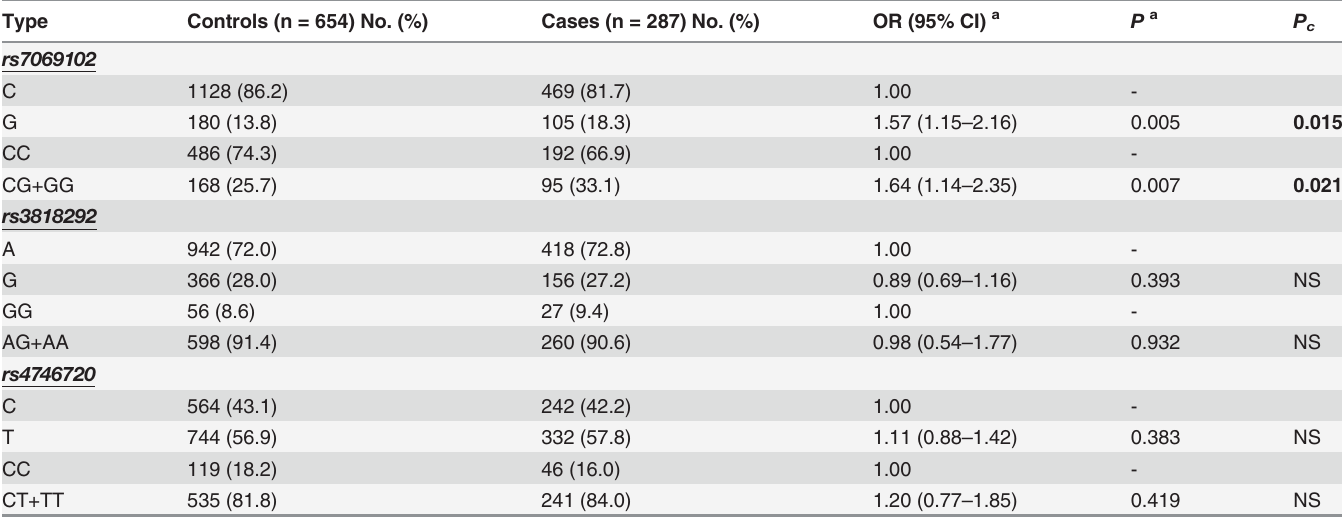
Table 2. Multivariate associations of the three tagSNPs in SIRT1 gene with the risk of MI. Type Controls (n = 654) No.